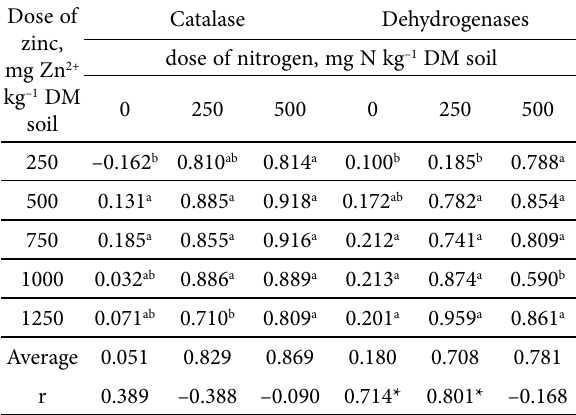
Table 4. Index of resilience (RL) of oxidoreductases in the soil contaminated with zinc after two weeks of incubation (the values are means of three replicates) Dose of